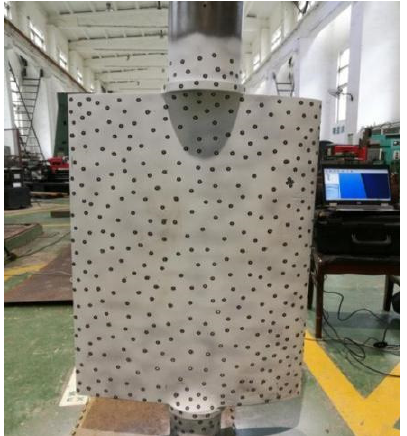
Figure 1. Scanned view of the site.